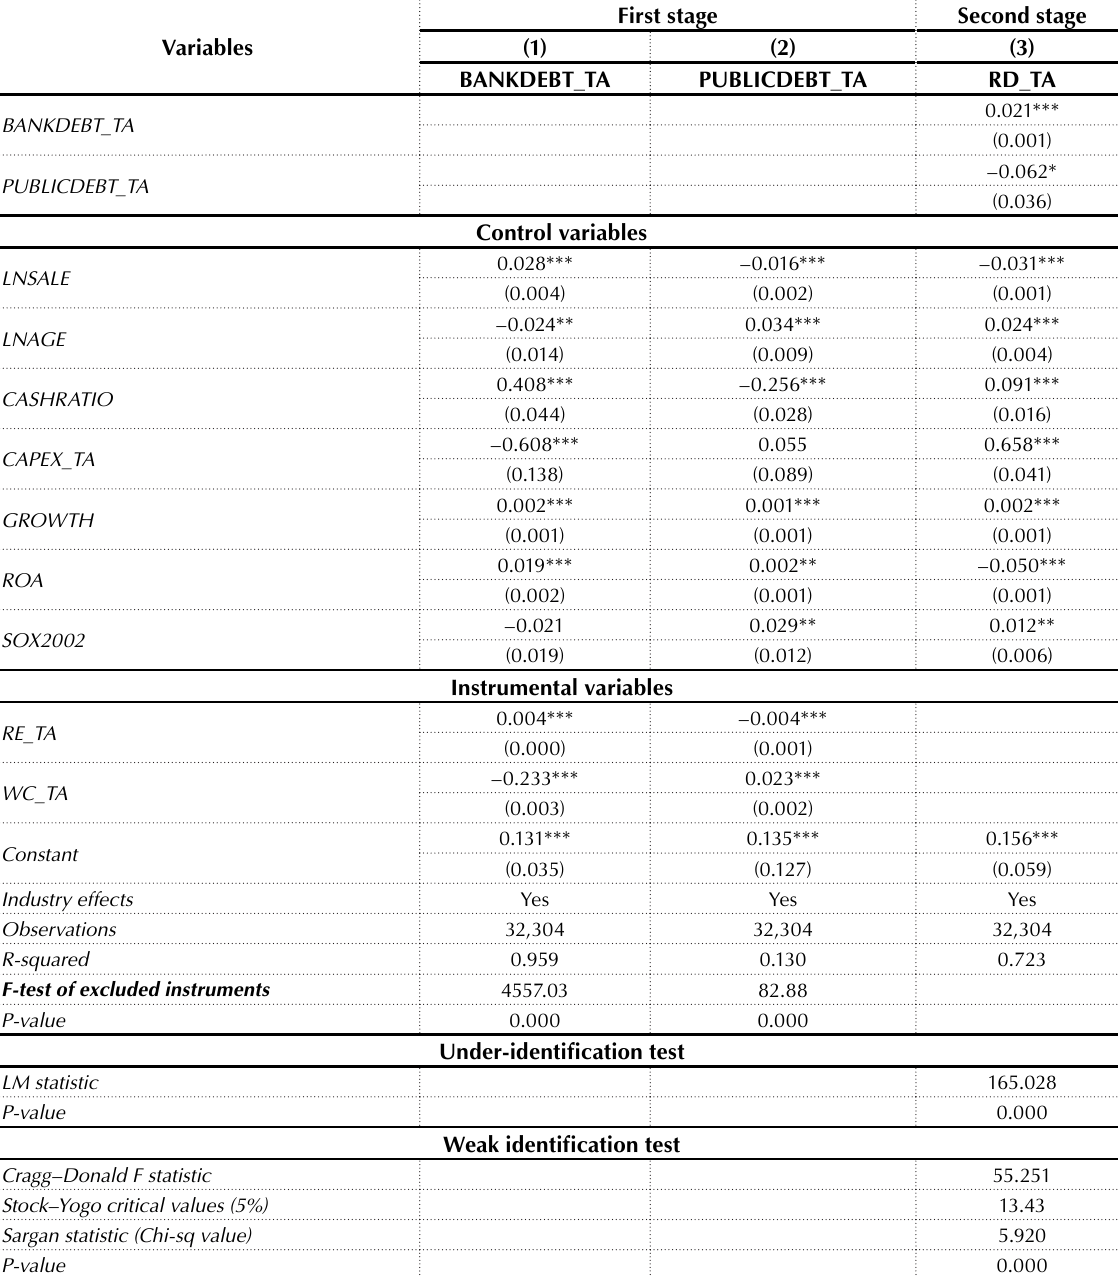
Table 3. Firm R&D investments and debt maturity